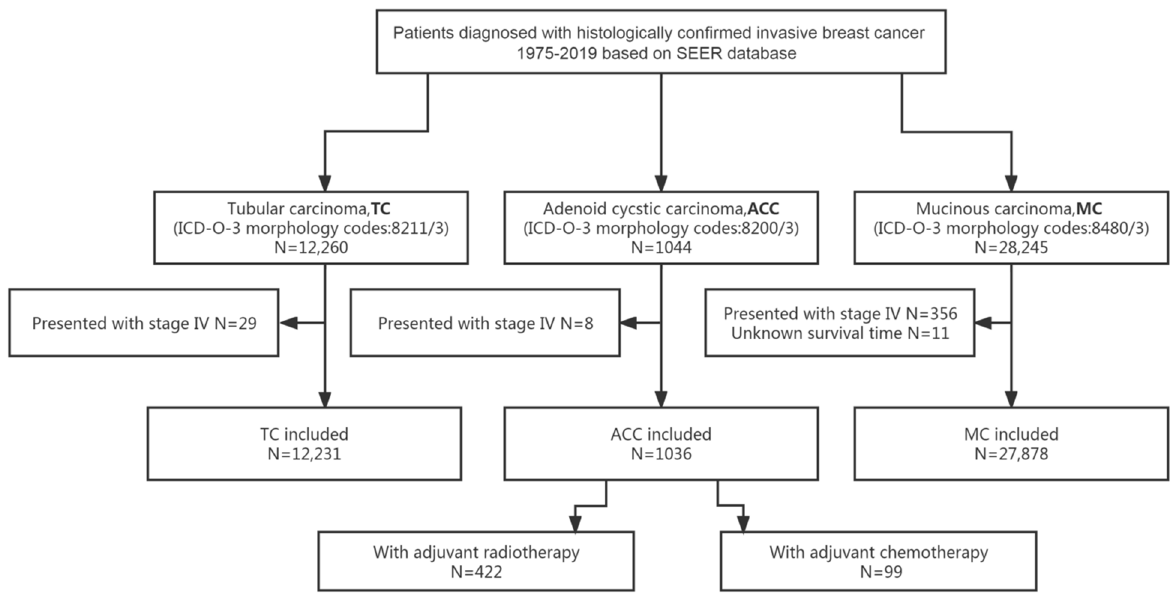
Figure 1. Flow diagram for the selection of the study cohort. Abbreviations: ACC = adenoid cystic carcinoma of the breast; ICD-O-3 = International Classification of Diseases for Oncology, third edition; MC = mucinous carcinoma of the breast; SEER = Surveillance, Epidemiology and End Results; TC = tubular carcinoma of the breast.